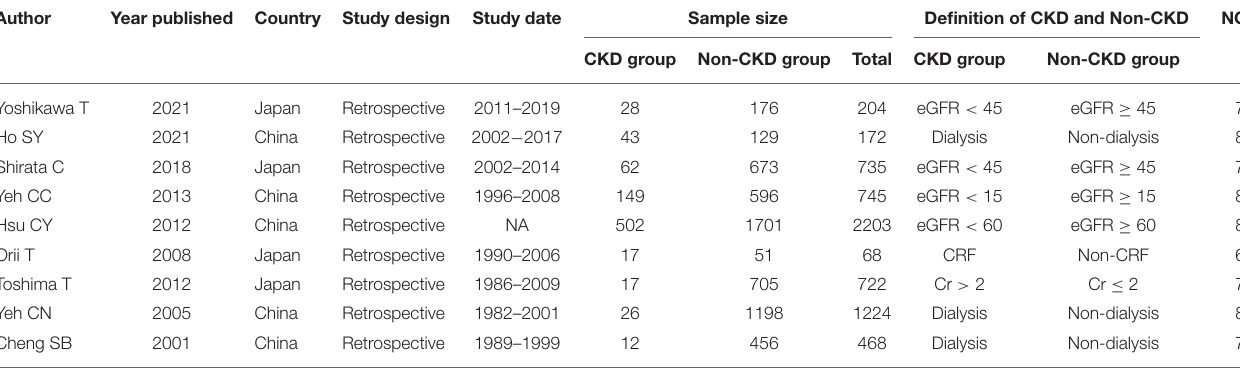
TABLE 1 | Characteristics of the studies included in the meta-analysis.